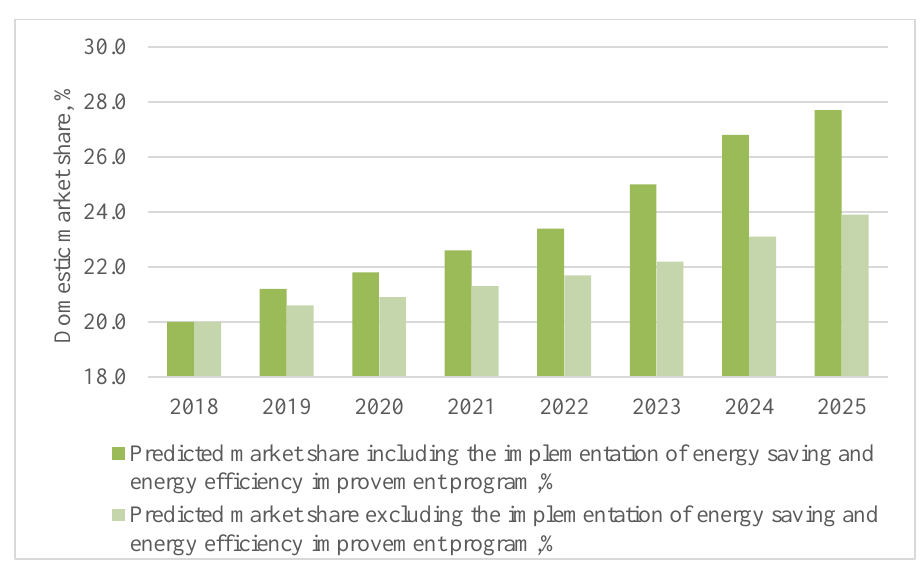
Figure 5. Predictive assessment of the impact of energy saving and energy e ffi ciency improvement program on the potential change in the company’s market share, % (source: compiled by the